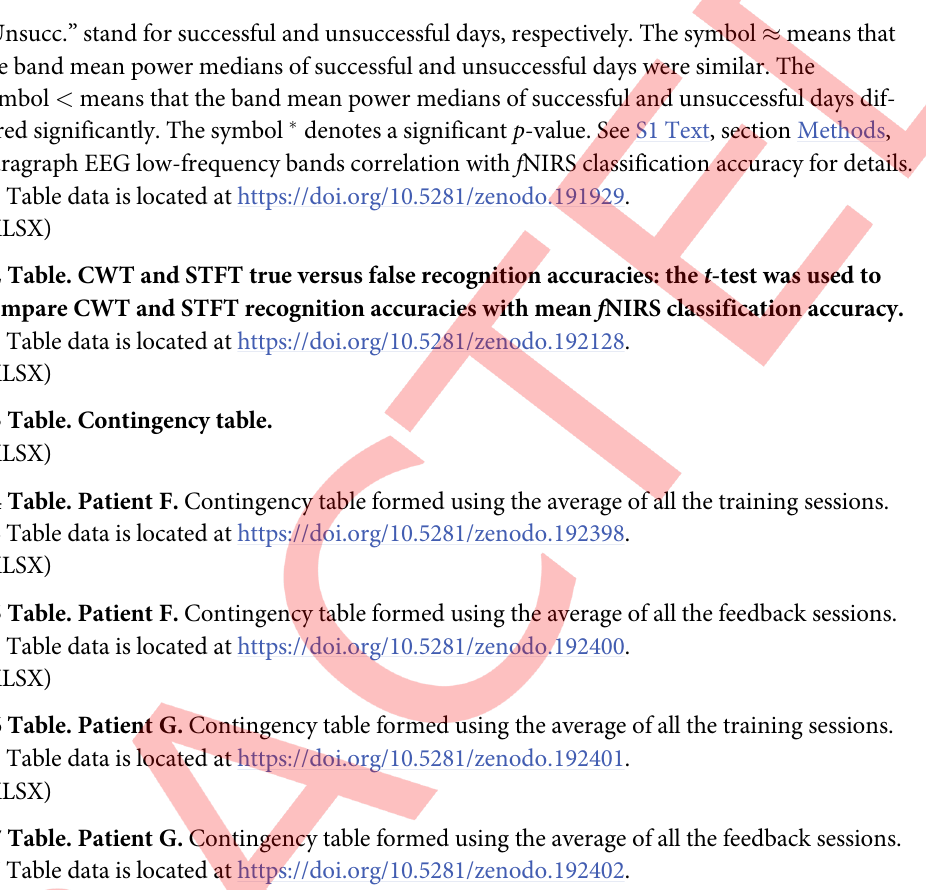
S3 Table. Contingency table. S4 Table. Patient F. Contingency table formed using the average of all the training sessions. S4 Table data is located at https://doi.org/10.5281/zenodo.192398. S5 Table. Patient F. Contingency table formed using the average of all the feedback sessions. S5 Table data is located at https://doi.org/10.5281/zenodo.192400. S6 Table. Patient G. Contingency table formed using the average of all the training sessions. S6 Table data is located at https://doi.org/10.5281/zenodo.192401. S7 Table. Patient G. Contingency table formed using the average of all the feedback sessions. S7 Table data is located at https://doi.org/10.5281/zenodo.192402. S8 Table. Patient B. Contingency table formed using the average of all the training sessions. S8 Table data is located at https://doi.org/10.5281/zenodo.192406. S9 Table. Patient B. Contingency table formed using the average of all the feedback sessions. S9 Table data is located at https://doi.org/10.5281/zenodo.192407. S10 Table. Patient W. Contingency table formed using the average of all the training sessions. S10 Table data is located at https://doi.org/10.5281/zenodo.192408. S11 Table. Patient W. Contingency table formed using the average of all the feedback ses-